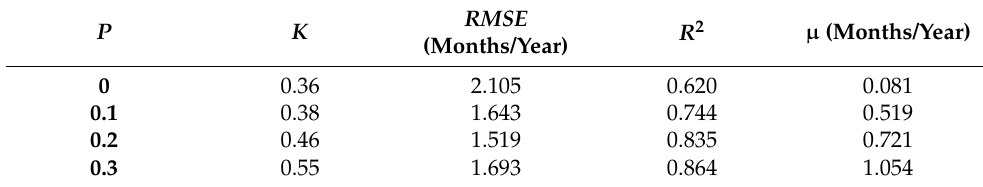
Figure 17. Superimposition of the RMSE surface (black contour lines) and the R 2 surface (red contour lines) for the frequency- equivalent climate. The x -axis is the groin permeability P , while the y -axis is the GENESIS transport coefficient K . Surfaces were obtained by comparing the “measured” and “predicted” LRR functions of each K – P scenario. Table 4. Performance indices ( RMSE , R 2 , and mean) for the frequency-equivalent climate.